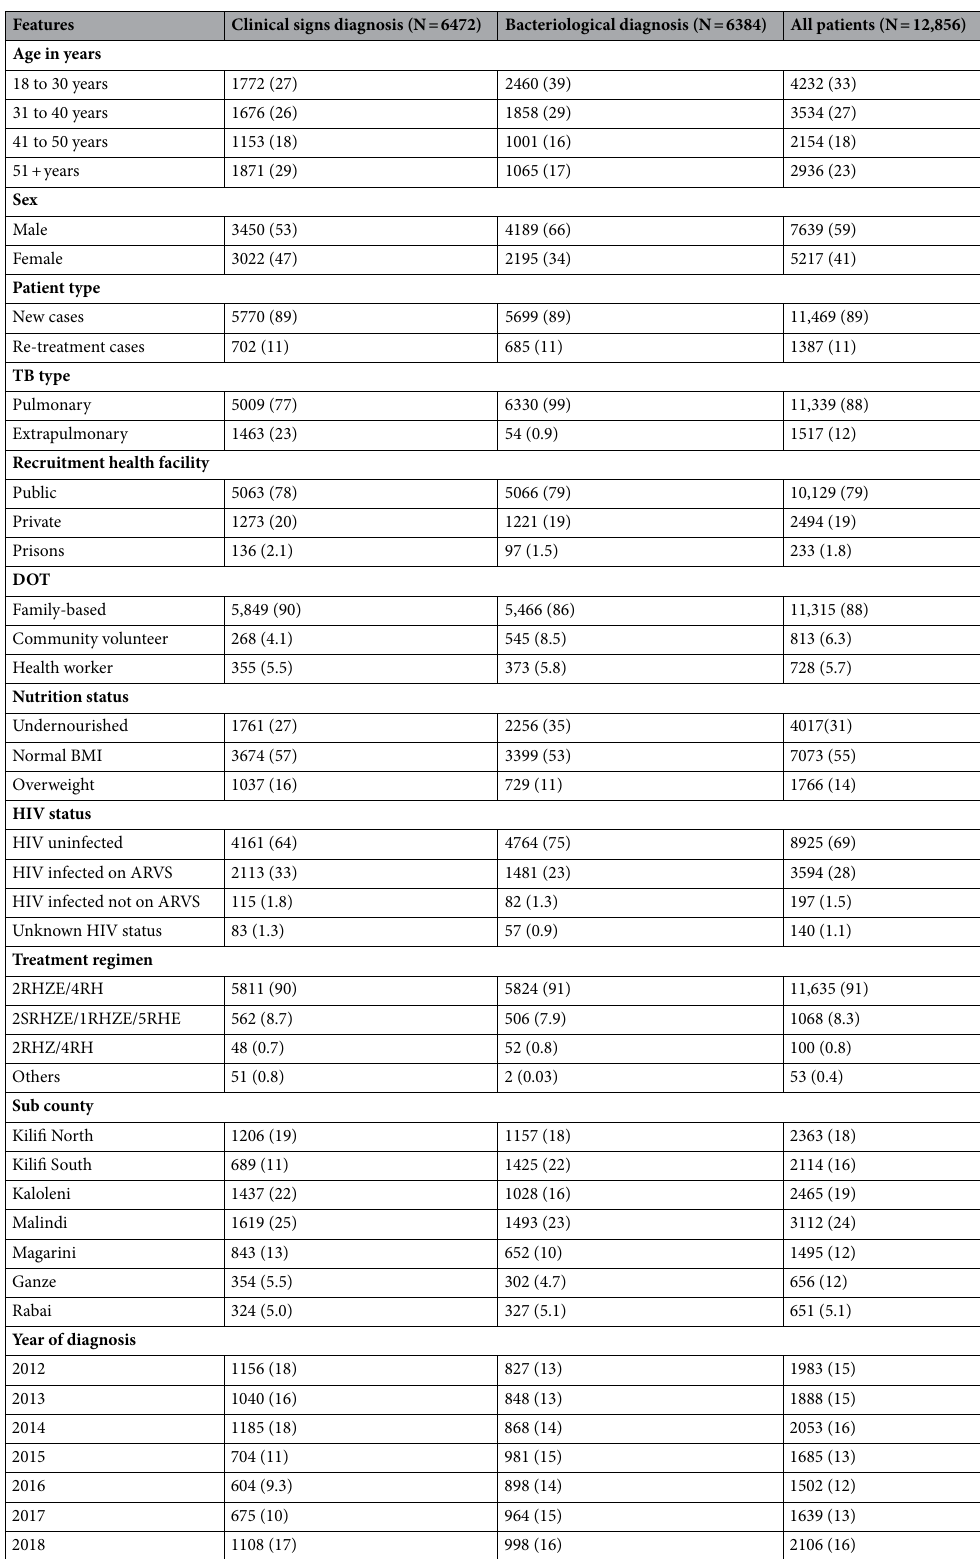
Table 1. Study participants characteristics at the time of starting anti-TB treatment. DOT direct observed treatment, BMI body mass index, ARVs